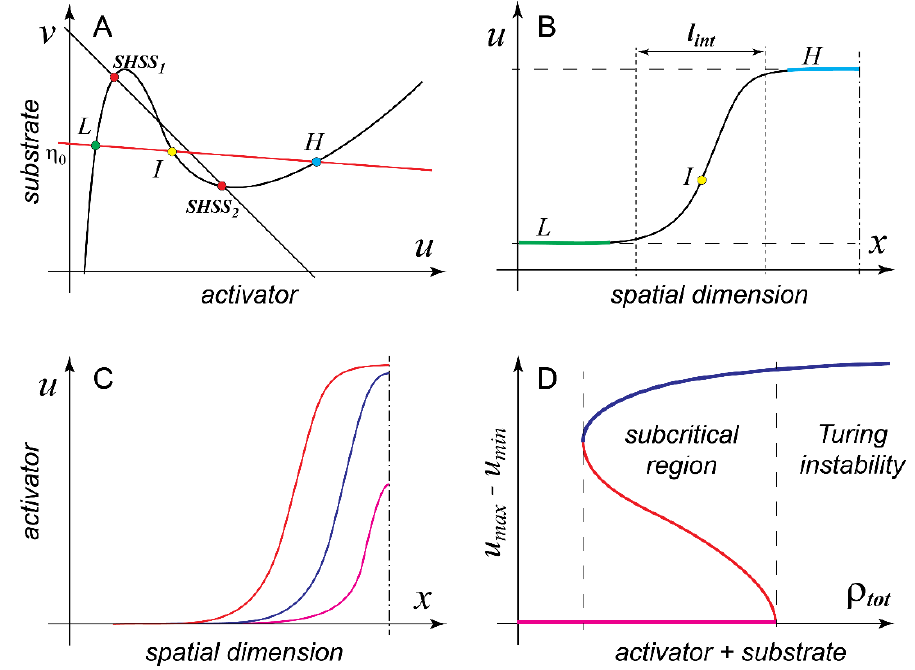
Figure 2. Spatial patterns formed by model (1). ( A ) Pattenrs formed by model B on a large spatial domain are determined in the phase plane ( u , v ) by the intersections of the reaction function and the line of patterns v = η 0 − D u / D v v shown in red (see text). Circles L and H represent low and high plateaus of the spatial pattern, circle I corresponds to the inflection point of the mesa pattern. Red circles represent steady states of the model in the well-mixed regime. ( B ) Mesa pattern formed by model B consist of low and high plateaus connected by interfaces with characteristic width (cid:96) int . ( C ) Model (1) forms stable peaks rather than mesas then it cannot reach saturation. Red curve represents mesa; blue curve represents a peak very close to saturation; magenta curve represents a peak far from saturation. Dash-dotted line in ( B,C ) represents an axis of pattern mirror symmetry. ( D ) Model (1) typically possesses a domain of parameters where both the SHSS (magenta) and the pattern (blue) are stable. Red curve represents unstable pattern (see text).